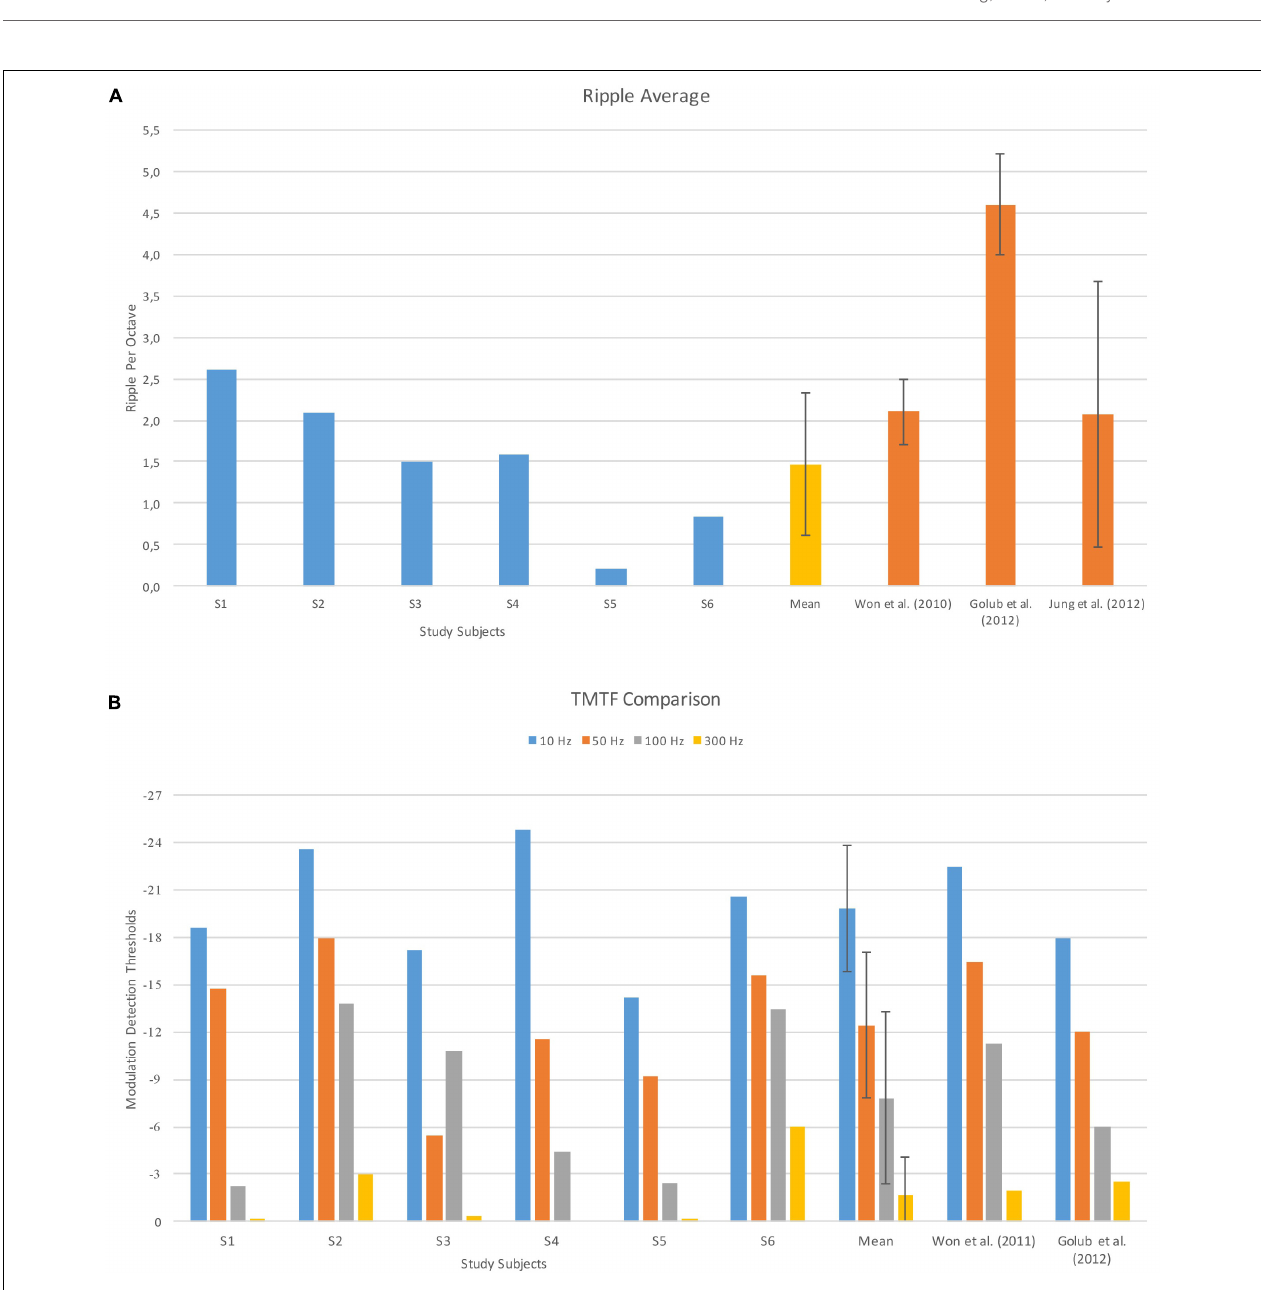
FIGURE 4 | Spectral ripple discrimination (A) and TMTF (B) performance of study subjects and mean scores from previous studies. Error bars indicate ± 1 standard deviation. Data adopted from Won et al. (2010), Golub et al. (2012), and Jung et al.